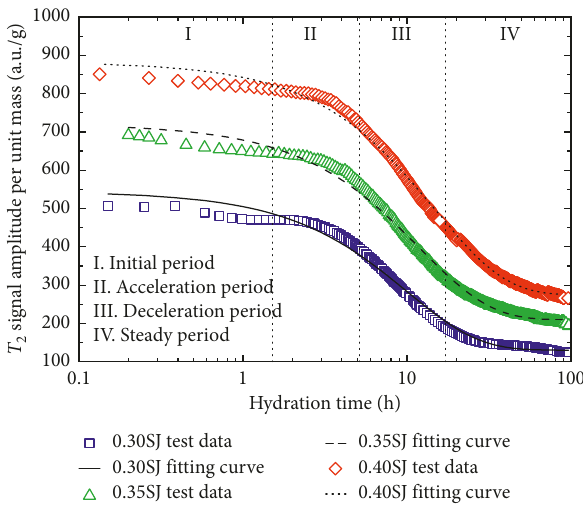
Figure 7: Experiment data and fitting curves of pure cement pastes with different w/c. Table 7: Fitting parameters and correlation of pure cement pastes with different w/c.